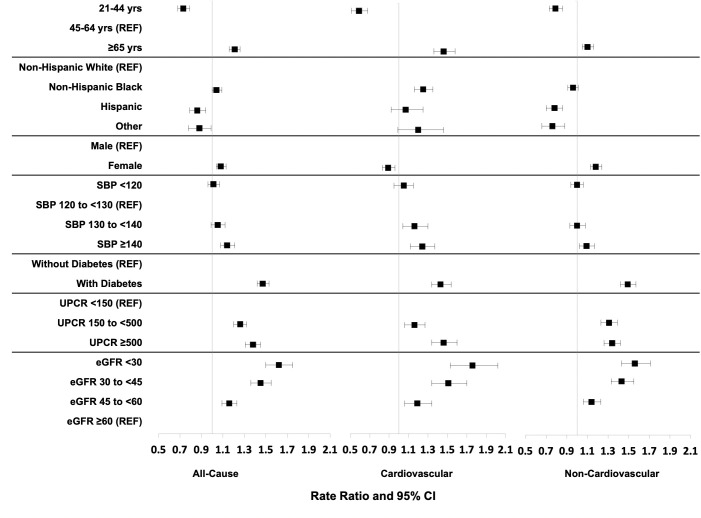
Plot of adjusted all-cause, cardiovascular, and non-cardiovascular hospitalization rate ratios.Error bars indicate 95% confidence intervals. Models adjusted for age, race, sex, clinical center, education, SBP, diabetes, UPCR, and CRIC baseline eGFR. CRIC, Chronic Renal Insufficiency Cohort; eGFR, estimated glomerular filtration rate; SBP, systolic blood pressure; UPCR, urine protein-to-creatinine ratio.